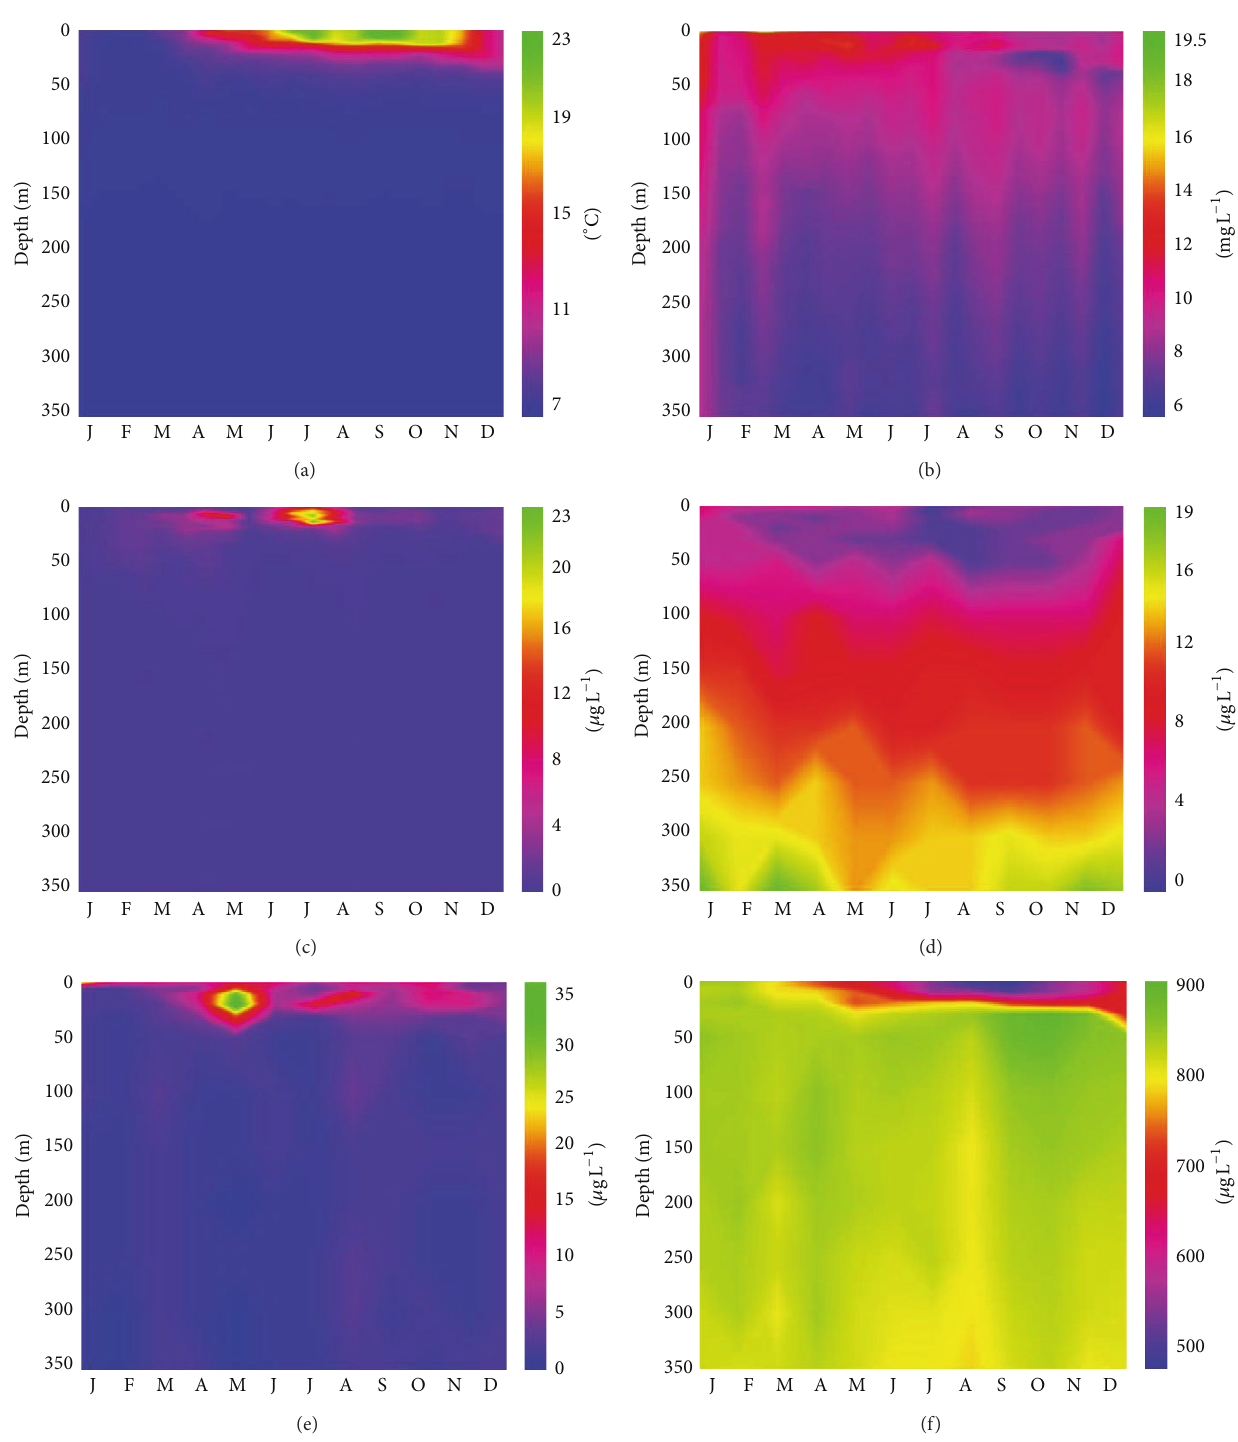
Figure 1: Intra-annual vertical profiles of physical and chemical parameters at the Ghiffa pelagic station during 2011 (45 ∘ 57 󸀠 N, 3 ∘ 46 󸀠 W: 370 m depth). Temperature in ∘ C (a), oxygen concentrations in mg L −1 (b), and chlorophyll 𝑎 concentrations in 𝜇 g L −1 (c) were measured every two weeks at intervals of 0.5 m. Concentrations of reactive phosphorous in 𝜇 gL −1 (d), ammonium in 𝜇 gL −1 (e), and nitrate in 𝜇 gL −1 (f) were measured at 0, 5, 10, 20, 30, 50, 10, 150, 200, 250, 300, and 350 m